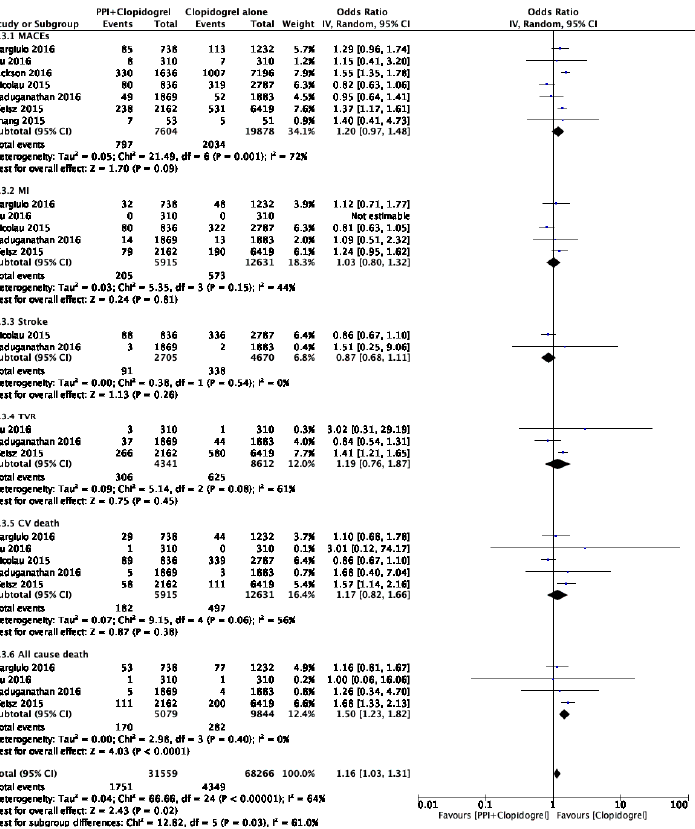
Figure 4. Forest plot illustrating the risk of cardiovascular events associated with the concomitant use of clopidogrel and PPIs using a random ‐ effects model. Zhang 2015 [9]; Gu 2016 [14]; Nicolau